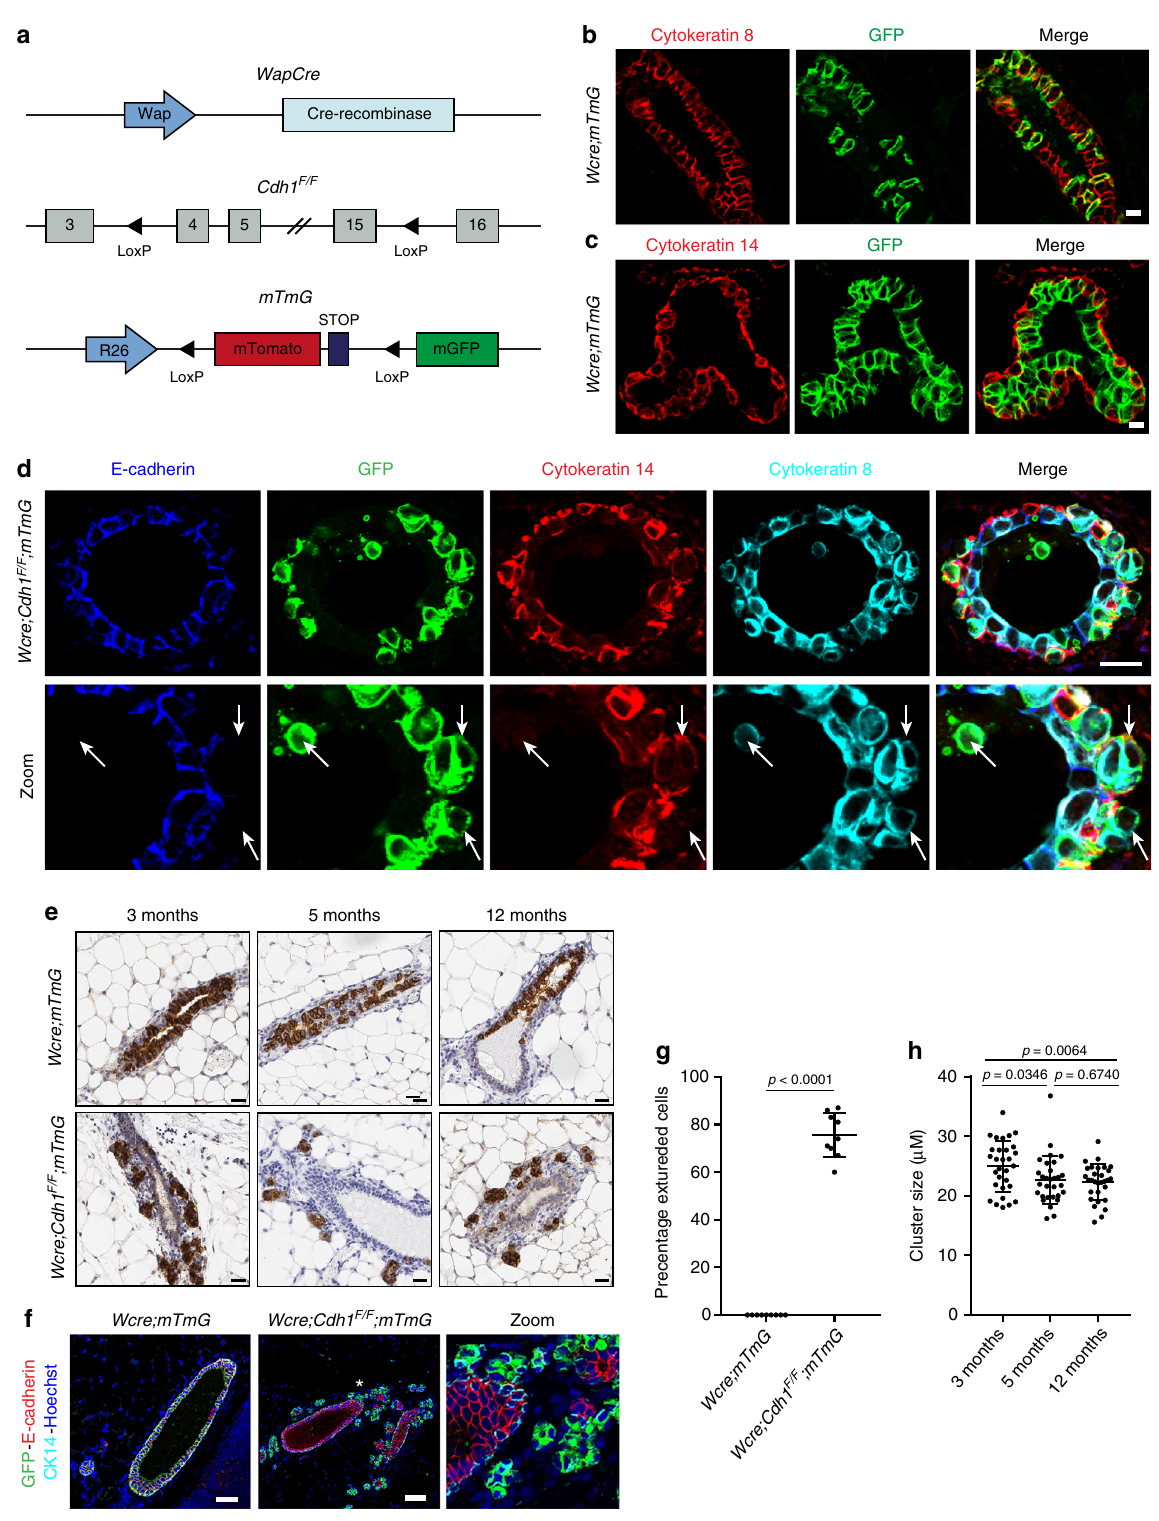
pro fi cient and -de fi cient subclones by picking GFP-positive MMECS in the presence of Y-27632 from Wcre;mTmG and Wcre;Cdh1 F/F ;mTmG MMECs (Fig. 3c). This allowed us to examine cell adhesion of cultured E-cadherin-de fi cient Wcre; Cdh1 F/F ;mTmG MMEC subclones in the presence and absence of Y-27632 (10 µM). All E-cadherin-de fi cient MMEC subclones displayed extensive cell blebbing during cell adhesion (Fig. 3d). In